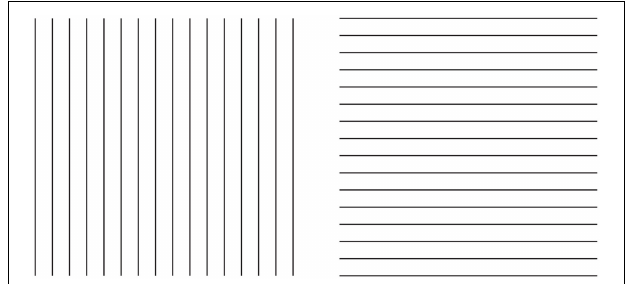
FIGURE 2 | Helmholtz’s square illusion shows the widening of the square made up of vertical lines and its lengthening when the lines are